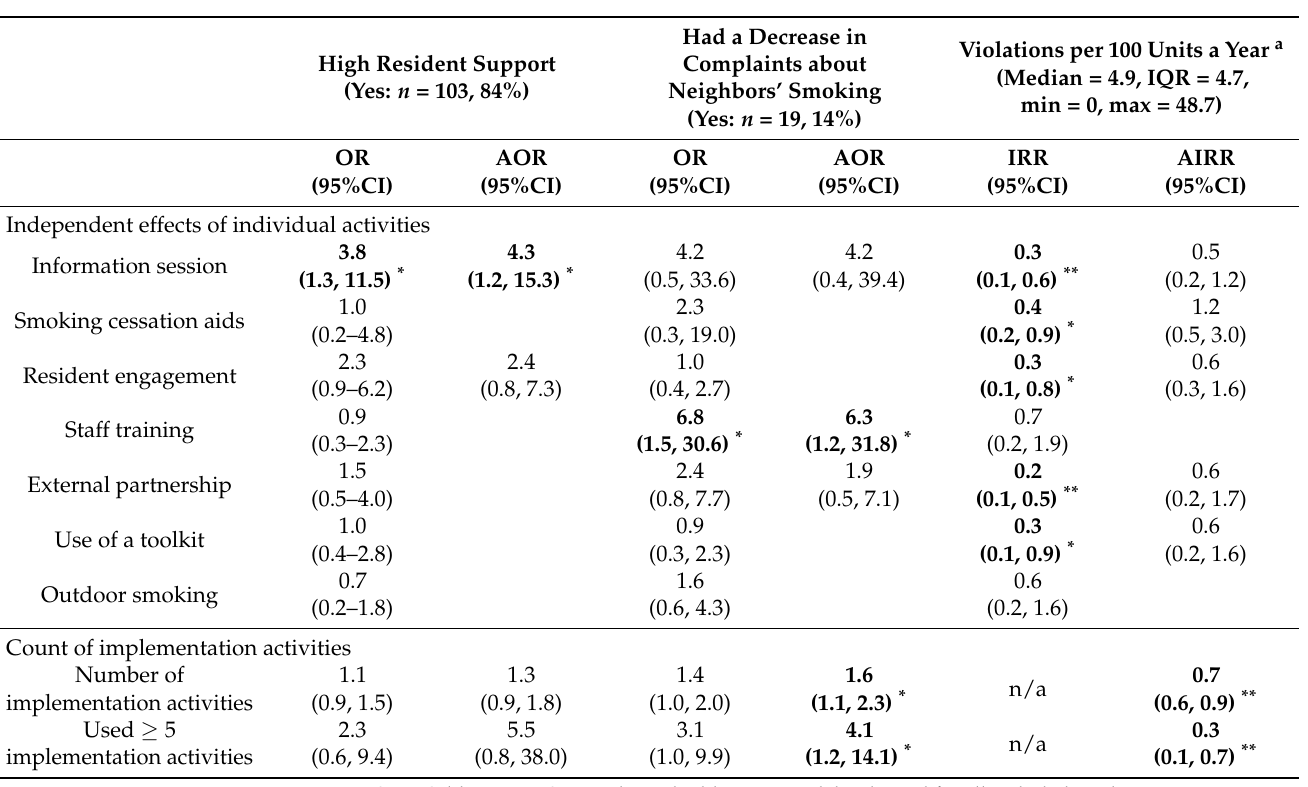
Table 2. Implementation activities and outcomes among public housing authorities with smoke-free policies for ≥ 1 year ( n =